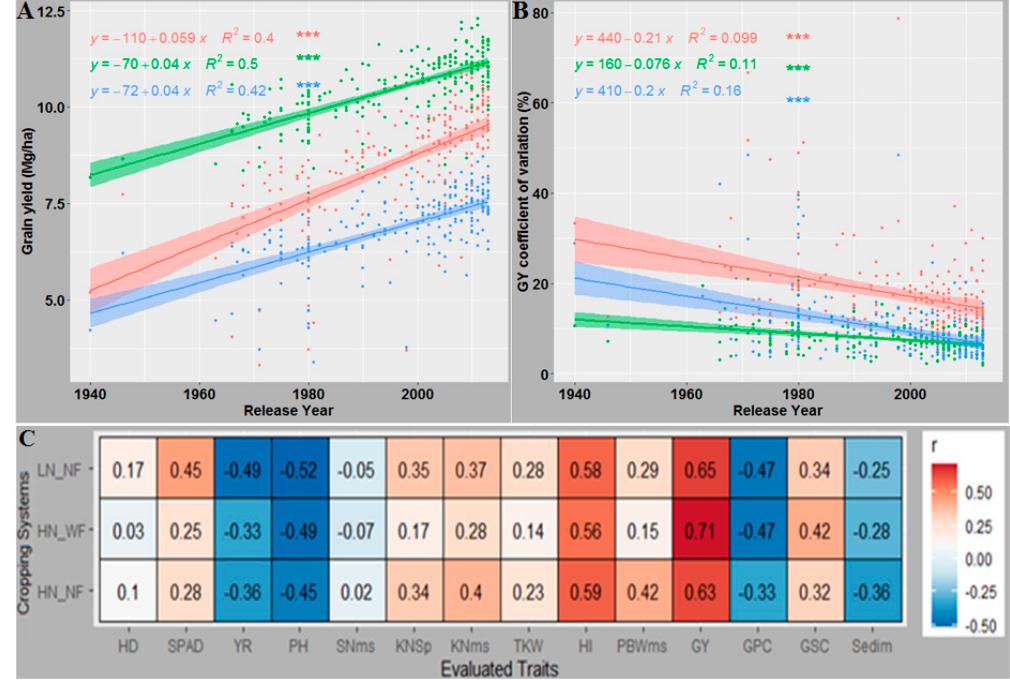
Figure 7. Temporal trends observed in traits of interest. ( A ) Average GY of three years per cultivars. ( B ) Average GY coefficient of variation per cultivars in relation their years of registration under three CS, HN-WF in green, HN-NF in red and LN-NF in blue color. ( C ) Correlations coefficients between year of release and fourteen traits of interest under three CS. The center lines represent the regression lines and the shaded regions in ( A , B ) represent the 95% confidence intervals. *** means the p value is significant at 0.001.